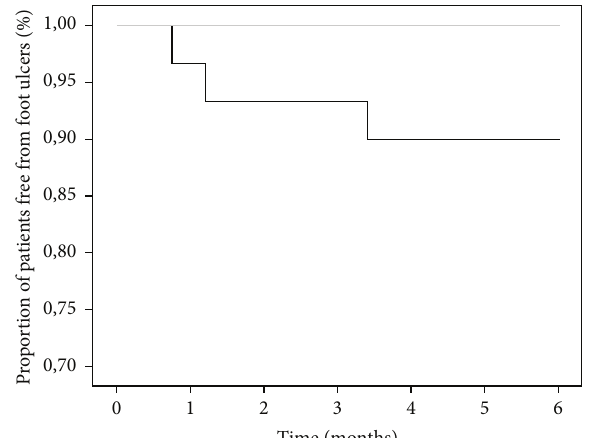
Figure 1: Kaplan-Meier survival curves (patients free of event) for incidence of foot ulcers in intervention (grey line) and control (black line) groups. 𝑝 = 0.012 .